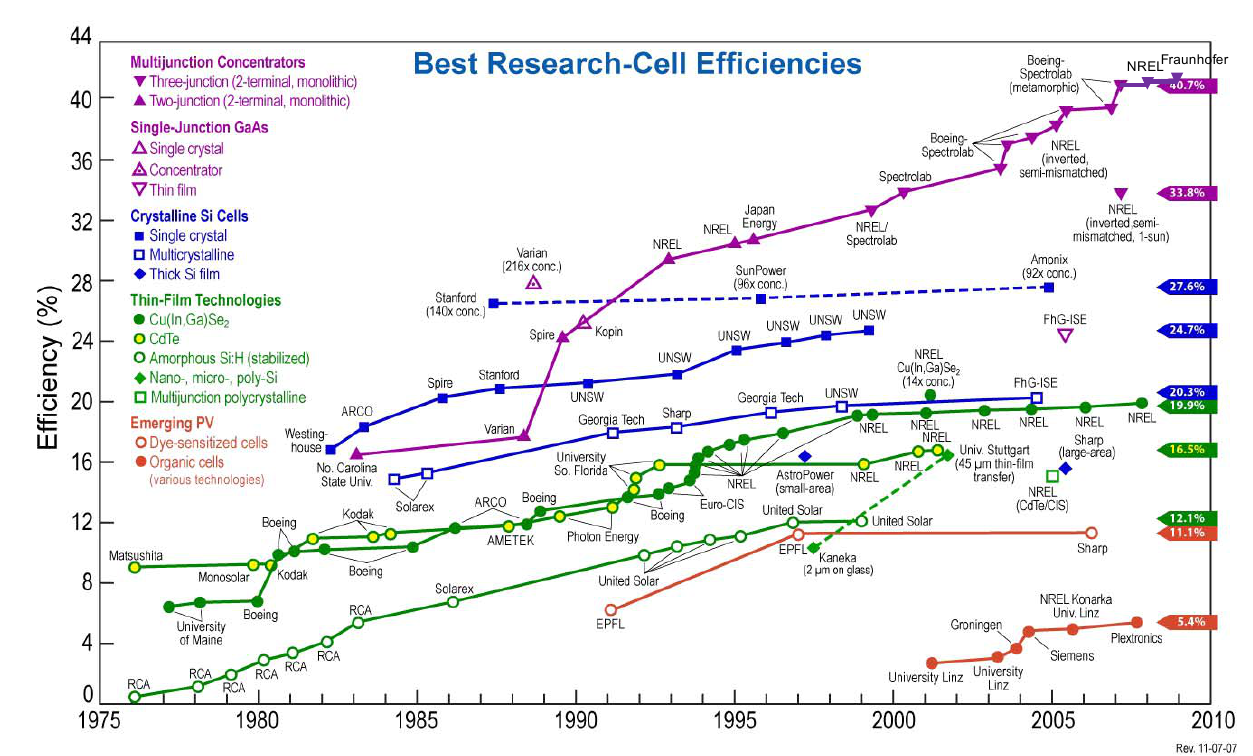
Figure 2. Chronological record energy-conversion efficiencies of solar cells. Two latest highest records have been added to the “Best Research-Cell Efficiencies” table available at http://en.wikipedia.org/wiki/Solar_cell. Originally generated by Sarah R. Kurtz, Lawrence L. Kazmerski et al. at National Renewable Energy Laboratory/National Center for Photovoltaics (as a work of the U.S. federal government, the image is in the public